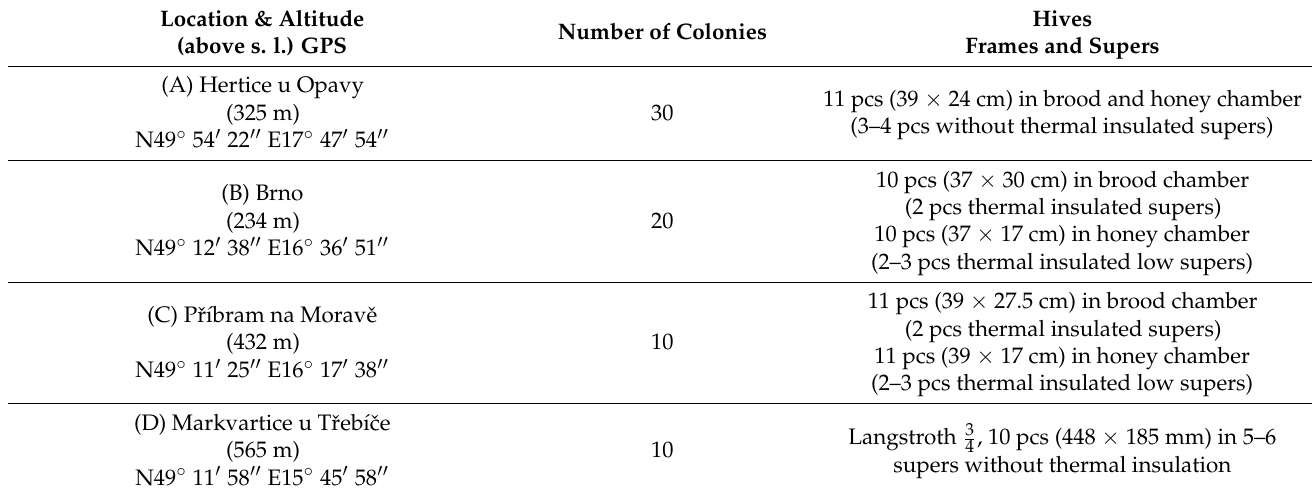
Table 1. Characterization of apiaries: municipality, GPS location, number of colonies at individual apiaries, and description of used hives (number and dimensions of used frames and supers).